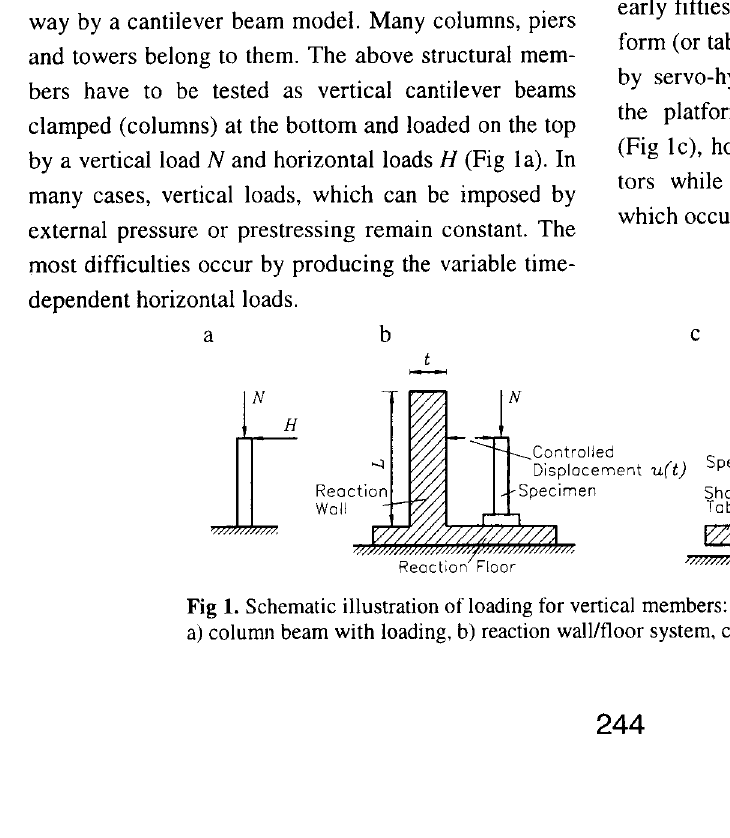
Fig 1. Schematic illustration of loading for vertical members: a) column beam with loading. b) reaction wall/floor system, c) shaking